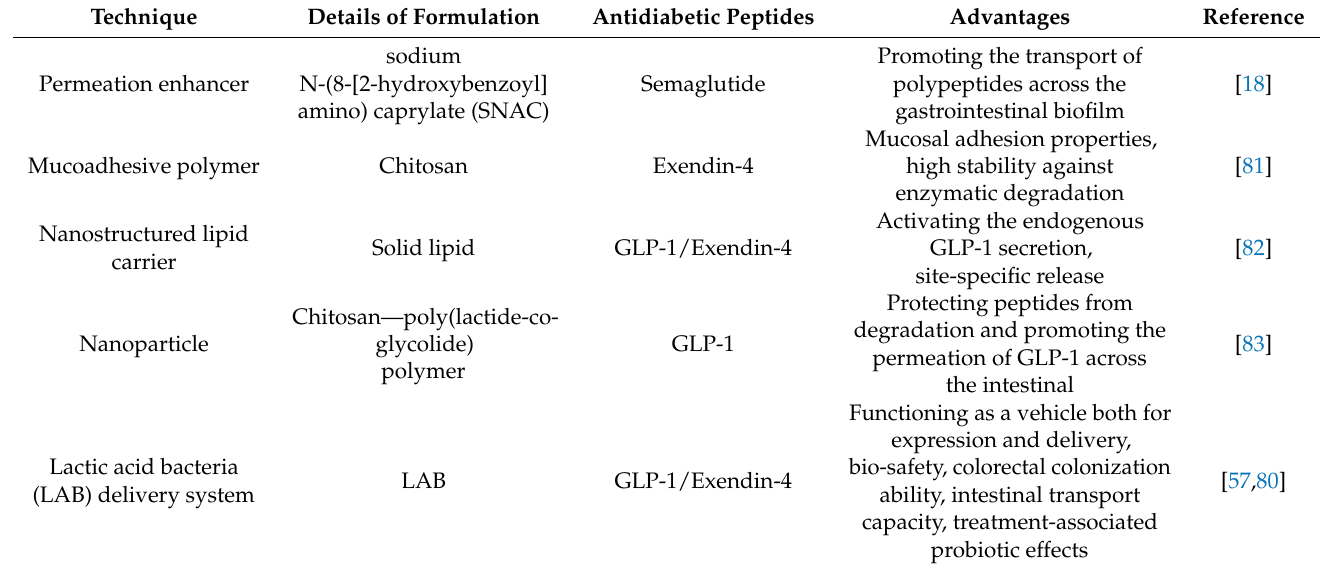
Table 2. A brief description of the oral mucosal delivery systems for GLP-1 receptor